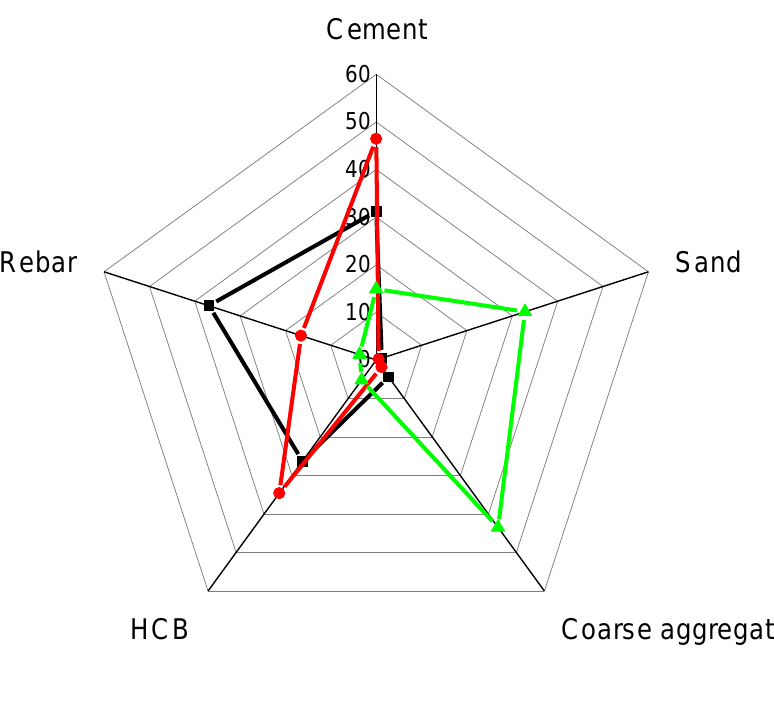
Figure 3. The percentile portions of the individual building materials to the total weight, embodied energy, and CO 2 emissions.